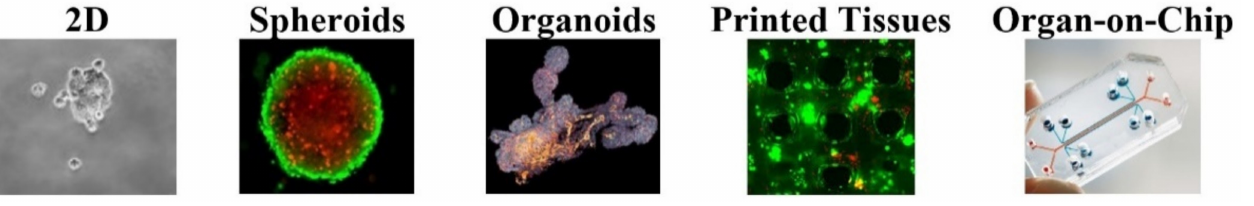
Figure 1. In vitro studying